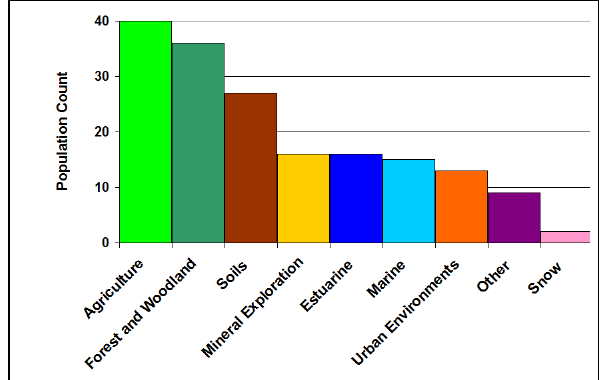
Figure 3.1 Areas of expertise self-nominated by survey